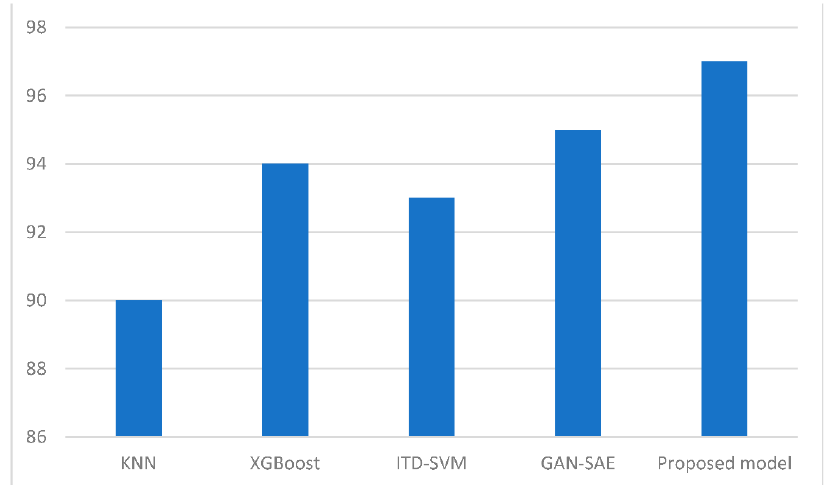
Figure 13. Comparison of AUC some state-of-the-art techniques.